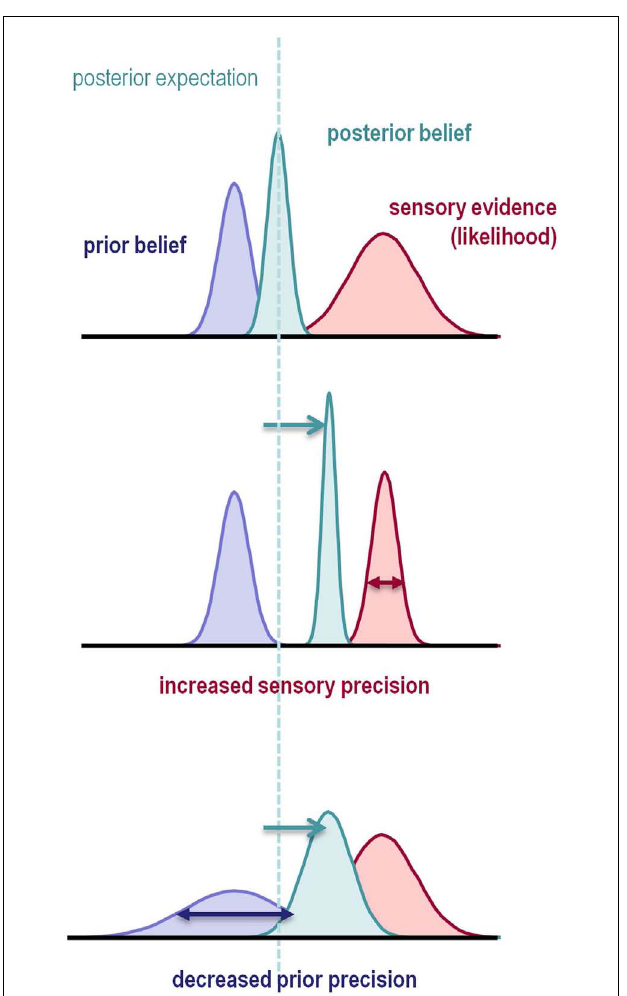
FIGURE 1 |This schematic illustrates the importance of precision when forming posterior beliefs and expectations .The graphs show Gaussian probability distributions that represent prior beliefs, posterior beliefs, and the likelihood of some data or sensory evidence as functions of some hidden (unknown) parameter.The dotted line corresponds to the posterior expectation, while the width of the distributions corresponds to their dispersion or variance. Precision is the inverse of this dispersion and can have a profound effect on posterior beliefs. Put simply, the posterior belief is biased toward the prior or sensory evidence in proportion to their relative precision.This means that the posterior expectation can be biased toward sensory evidence by either increasing sensory precision – or failing to attenuate it – or by decreasing prior